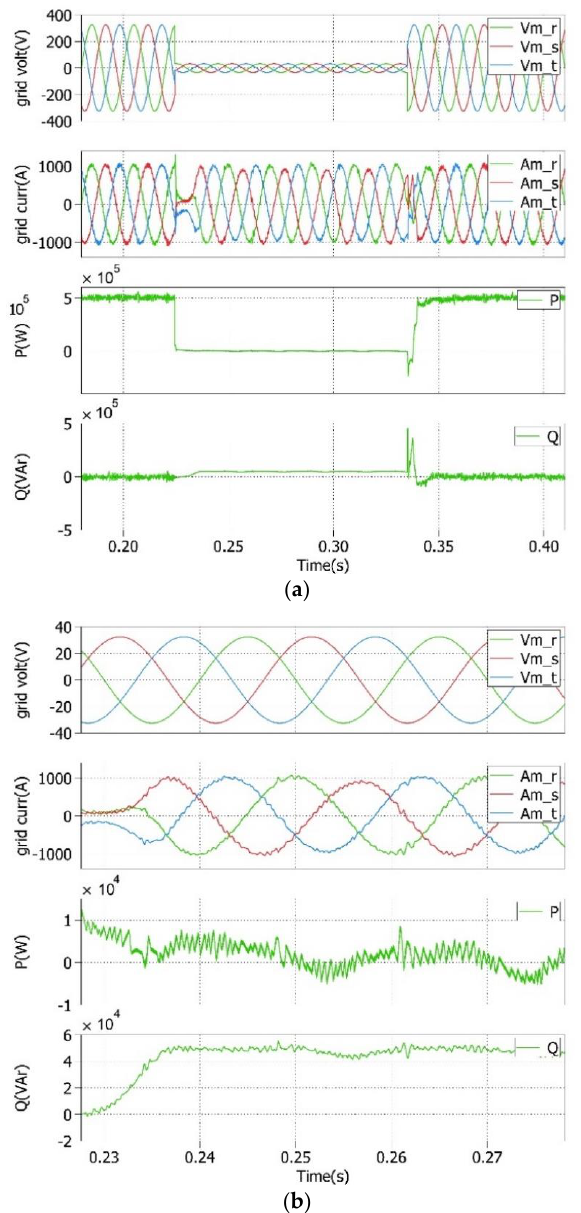
Figure 5. ( a ) Grid voltages and currents instantaneous active ( P ) and reactive ( Q ) powers during a symmetrical deep voltage sag of 90%; ( b ) detailed view during the faulty operating condition. In addition, Figure 6 shows the same variables when an asymmetrical deep voltage sag of 90% occurred in the amplitude of the grid voltage in phase three, whereas Figure 7 depicts the same case during an asymmetrical moderate voltage sag of 50%, also in the